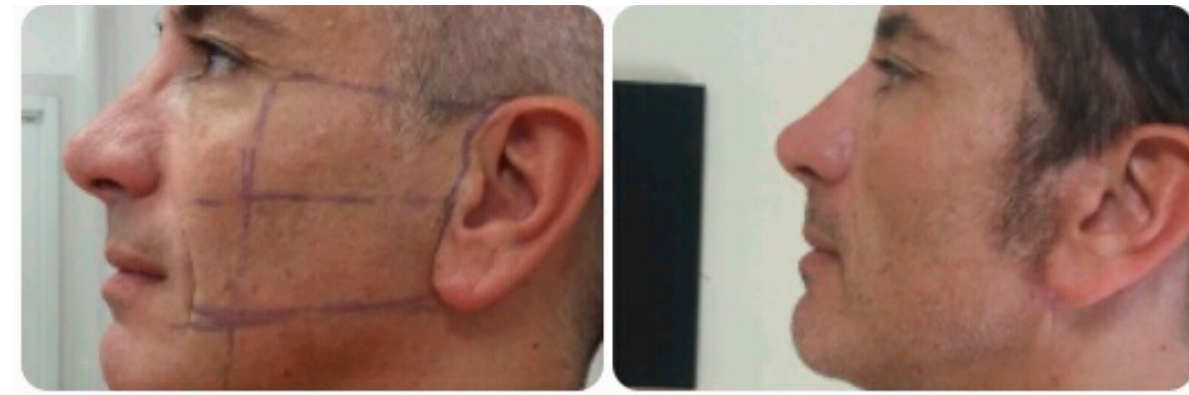
Figure 3. Preoperative and postoperative view.